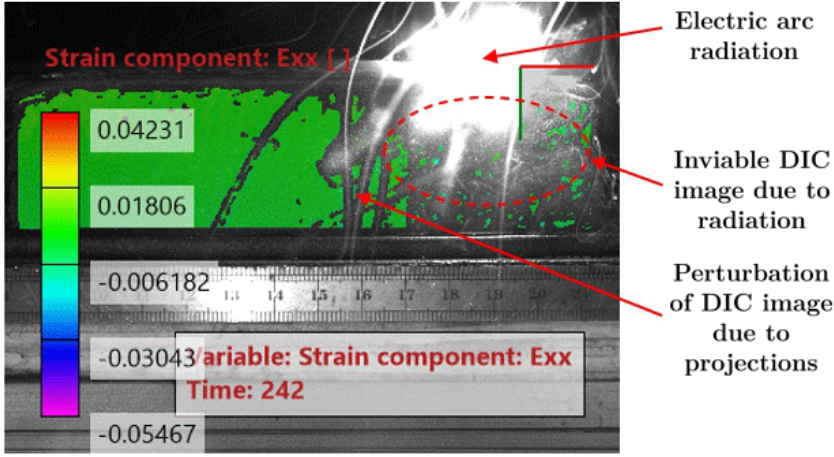
Figure 6. Strain in the horizontal direction calculated from the original image of Figure